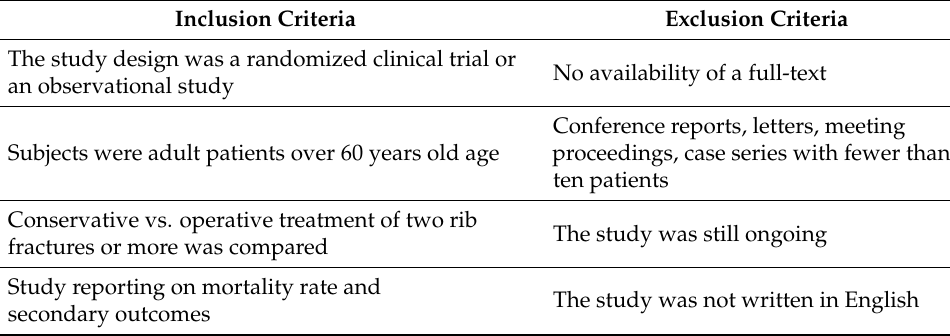
Table 2. Inclusion and exclusion